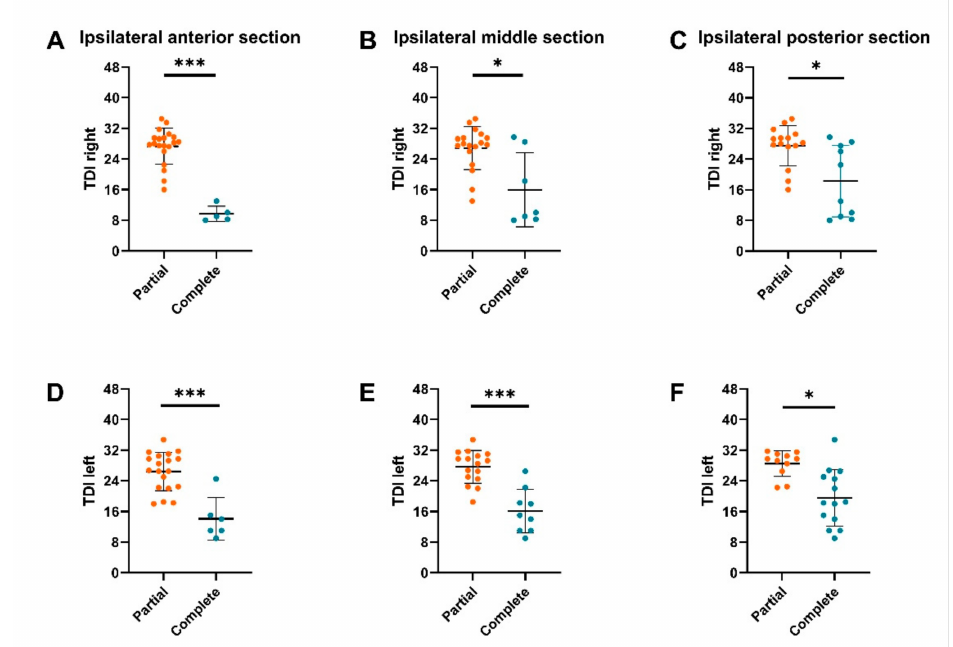
Figure 4. Monorhinal orthonasal olfactory function in CRS patients with partial or complete obstruction of the ipsilateral olfactory cleft (OC). Unilateral OC-opacification were assessed based on an anterior, middle, and posterior two-dimensional coronal plane. TDI left = orthonasal olfactory function of the left nostril, TDI right = orthonasal olfactory function of the right nostril. OC-opacification assessed in the ipsilateral anterior section ( A , D ), ipsilateral middle section ( B , E ), and ipsilateral posterior section ( C , F ). * p < 0.05, *** p < 0.01.